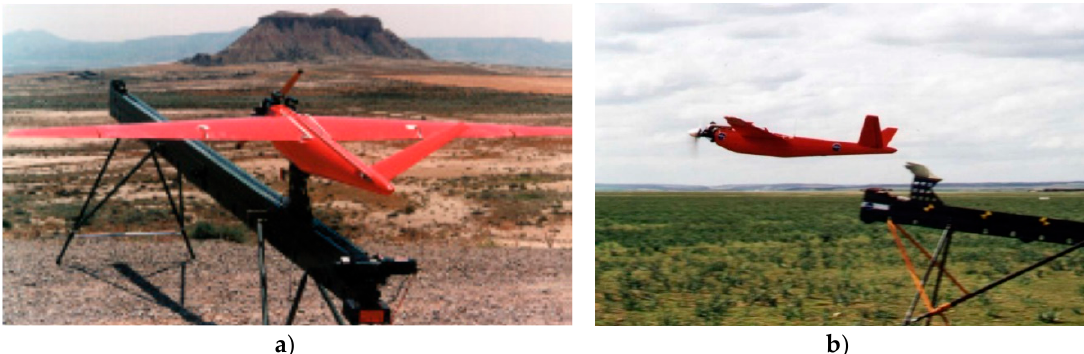
Figure 4: ( a ) ALO Avión Ligero Observación) RPA in the launching pad ( b ) ALO taking off. Table 6. ALO RPA technical characteristics.